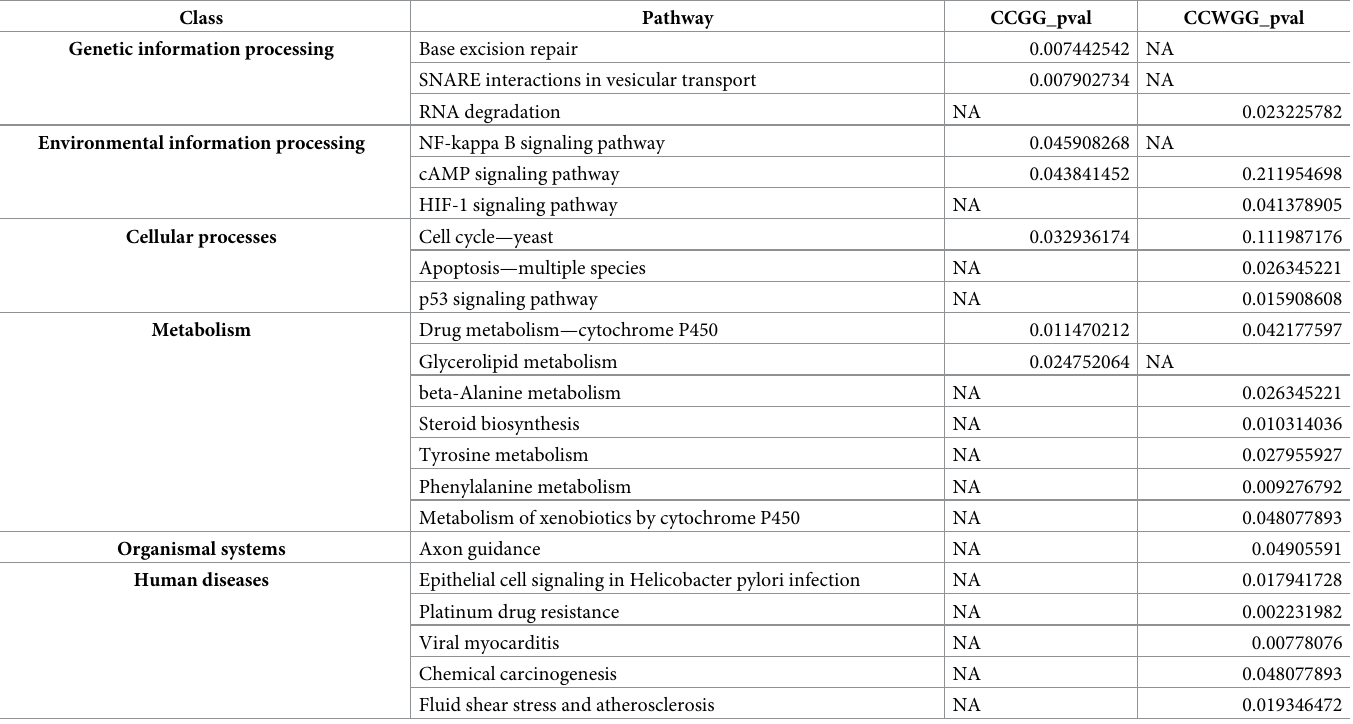
Table 4. Kegg enrichment of genes related to different methylation